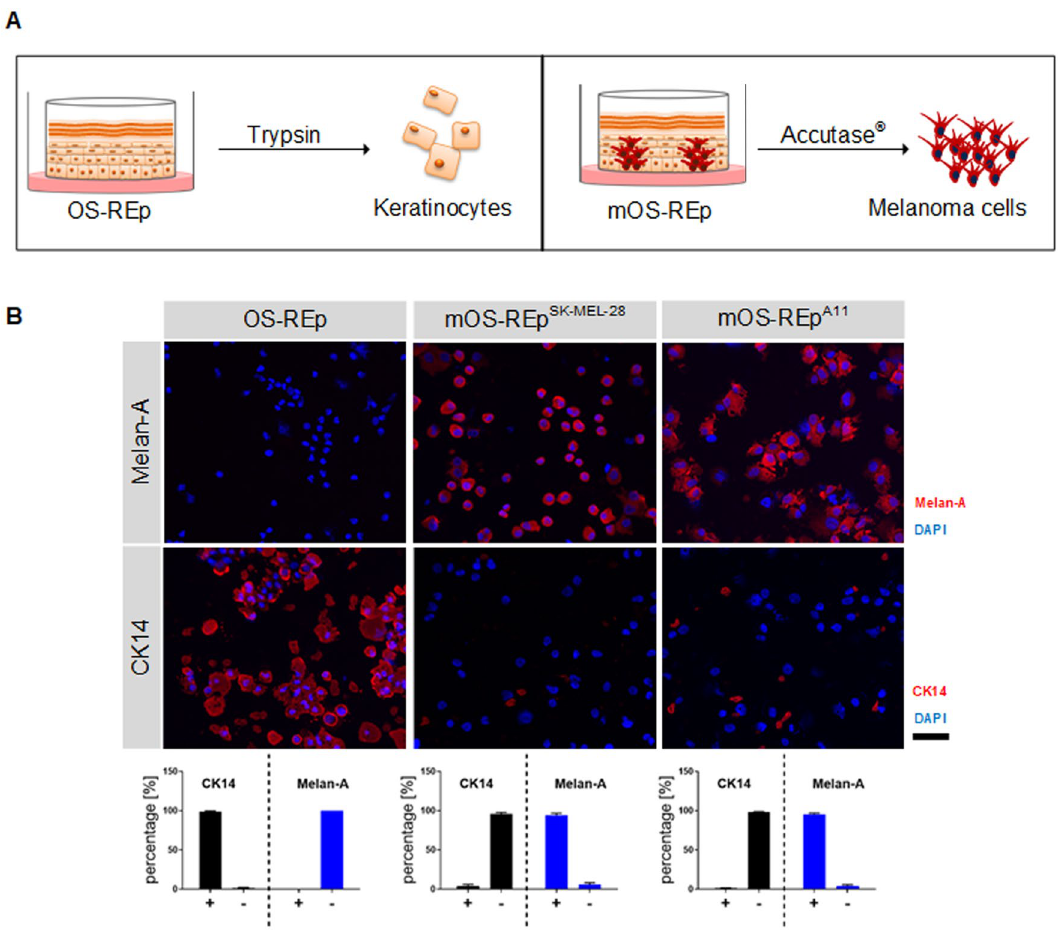
Figure 3. Re-Isolation of single cell suspensions via enzymatic digestion from melanoma and non-melanoma skin models. ( A ) Schematic of the re-Isolation process of single cells from the epidermal models. ( B ) Keratinocytes isolated via trypsin from OS-REp as well as melanoma cells isolated via accutase from mOS-REp were stained and quantified on cytospots with markers for keratinocytes (cytokeratin 14) and melanoma cells (Melan-A) (both in red). Cell nuclei were stained with DAPI (blue). Scale bar 50